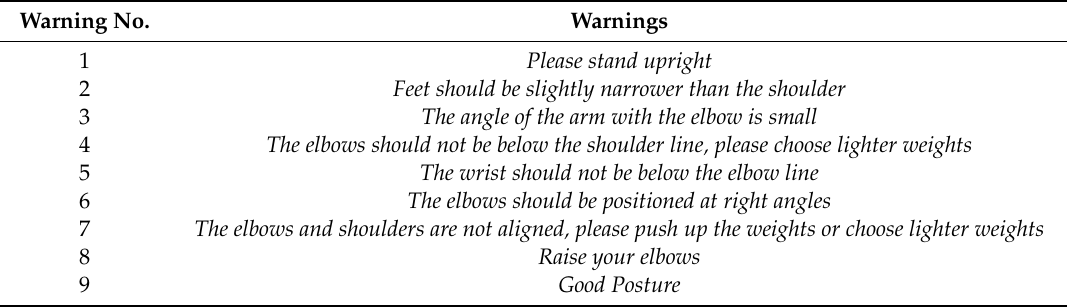
Table 2. Simultaneous Warnings Given to